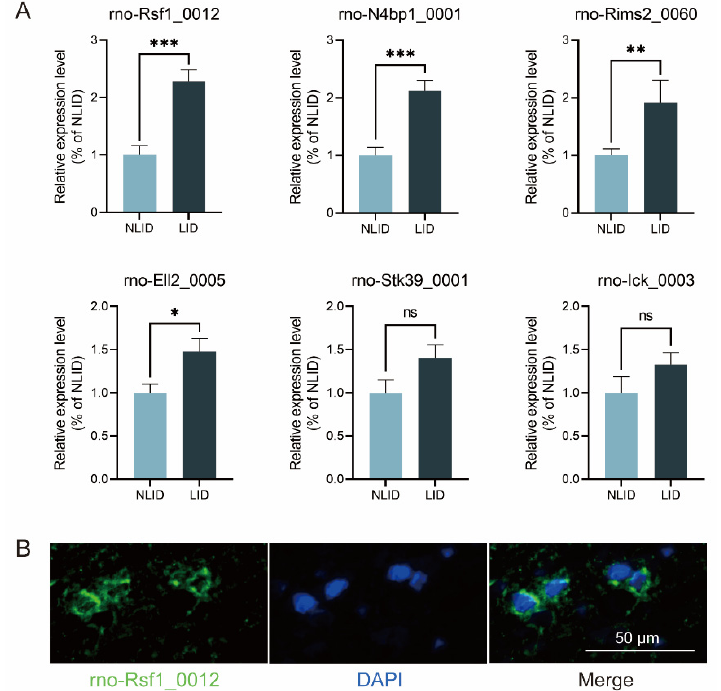
Figure 3. Expression profiles of rno-Rsf1_0012. ( A ) Validation of RNA sequencing results by qRT-PCR of six circRNAs. CircRNA rno-Rsf1_0012, rno-N4bp1_0001, rno-Rims2_0060, and rno-Ell2_0005 were significantly higher in the LID group ( n = 6) than in the NLID group ( n = 6). ( B ) Expression location of rno-Rsf1_0012. Immunofluorescence labeling of rno-Rsf1_0012 (green) and neuron markers (blue) in the striatum. * p < 0.05, ** p < 0.01, *** p < 0.001, ns